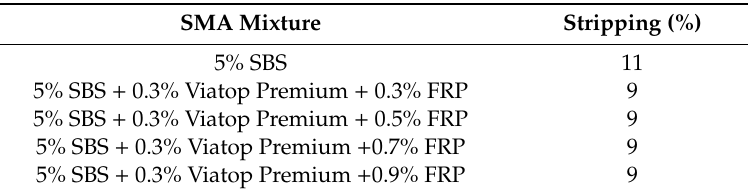
Table 6. Results of Nicolson stripping test.